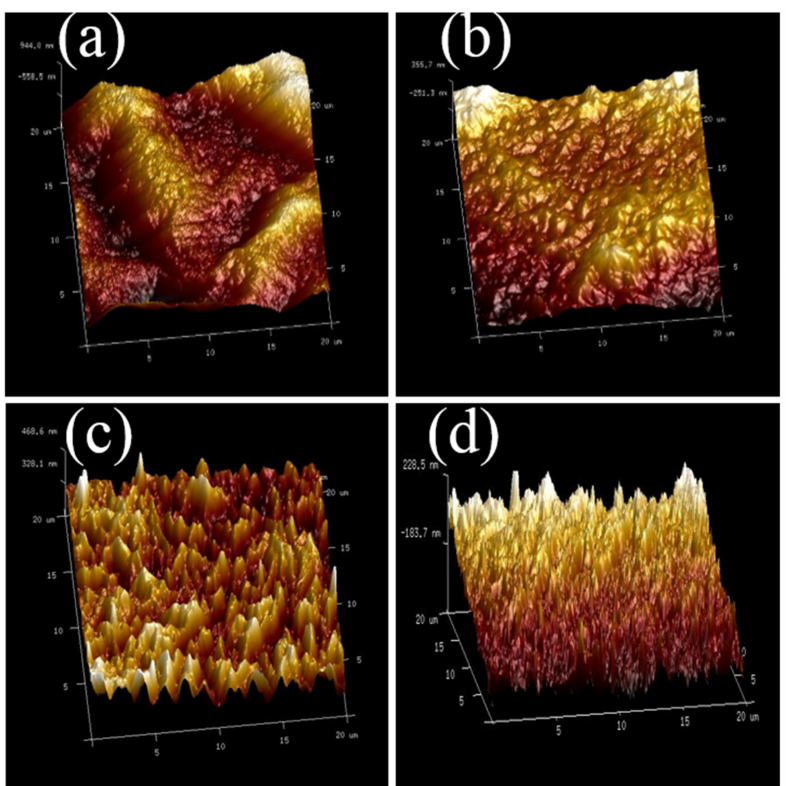
Figure 6. 3D morphology images of BWPU 5000 ( a ), BWPU 10,000 ( b ), PWPU 5000 ( c ) and PWPU 10,000 ( d ).